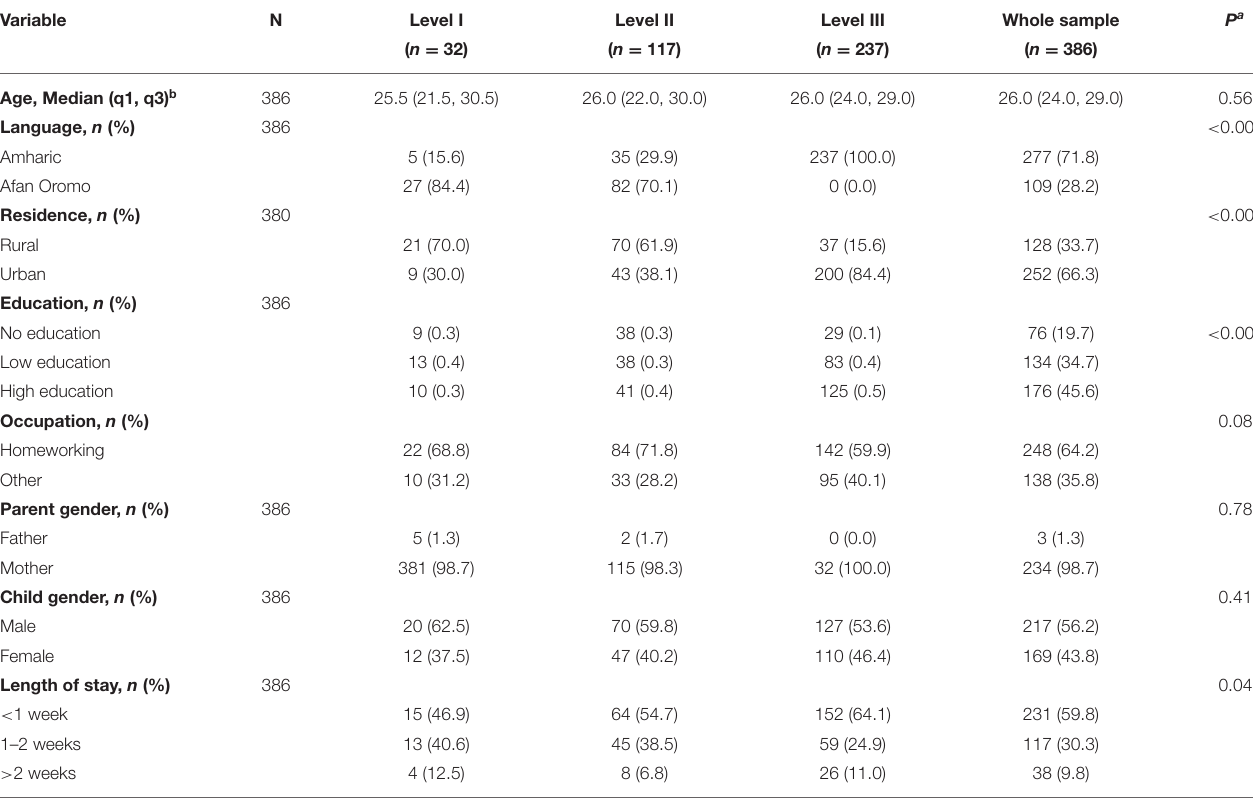
TABLE 1 | Socio-demographic characteristics of the respondents and child admission variables ( N = 386) in the whole sample and across the three NICU levels. Variable